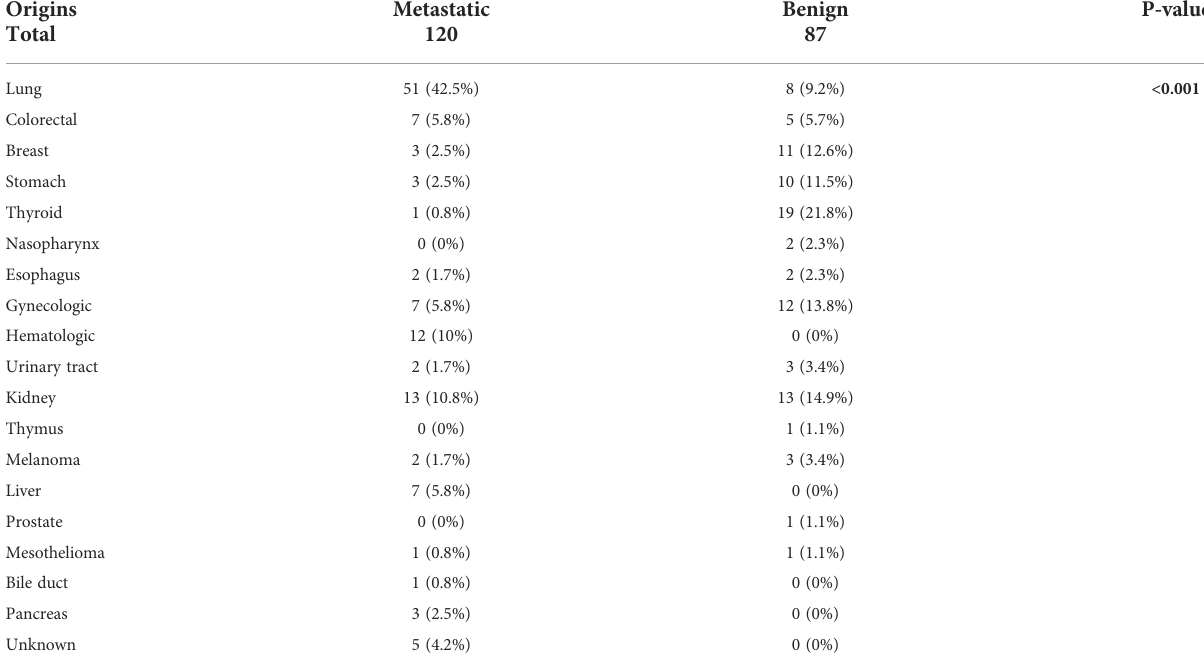
TABLE 1 The origin of fi rst primary cancers in patients with adrenal metastases and those with benign adrenal